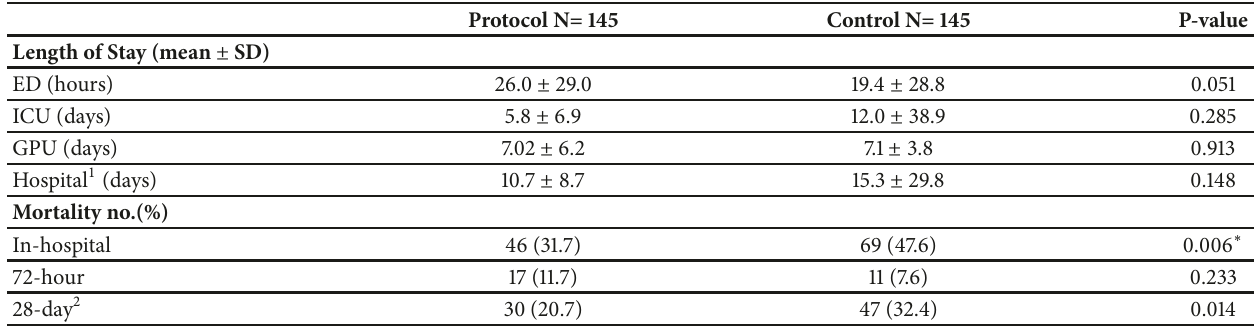
Table 4: Length of stay and mortality